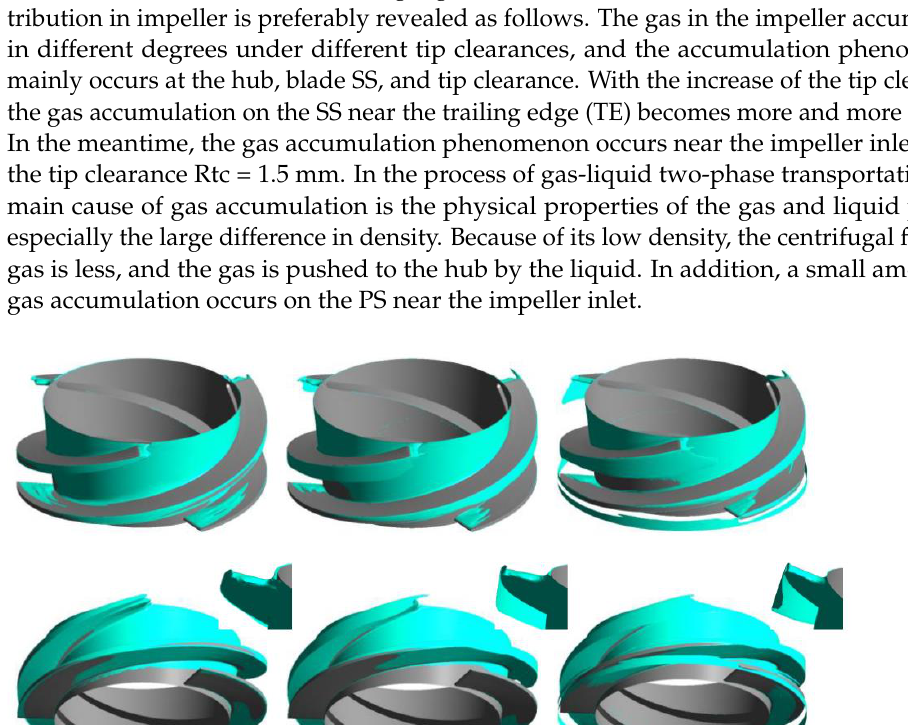
Figure 8. Multiphase pump pressurization performance.